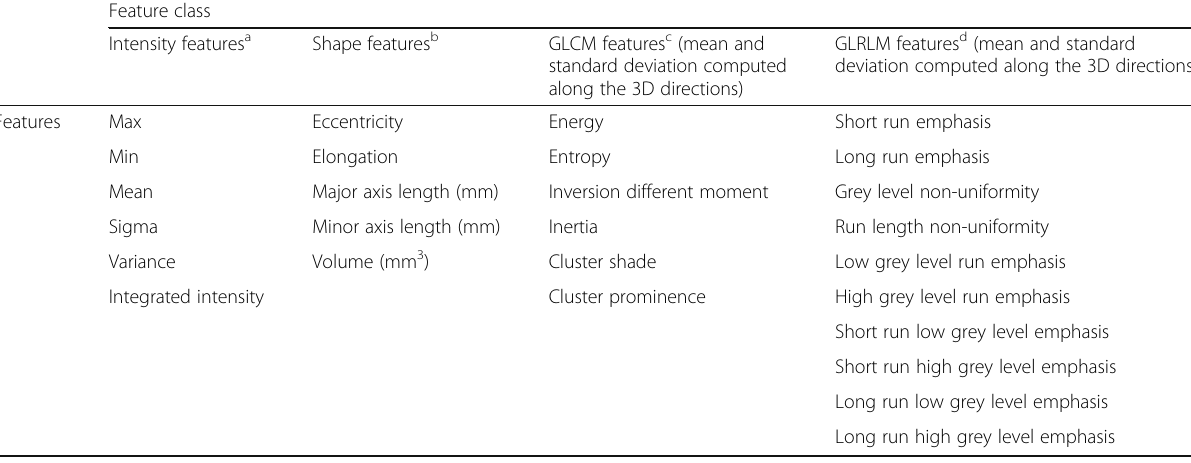
Table 1 Features extracted from each image and time-point of the series Feature class